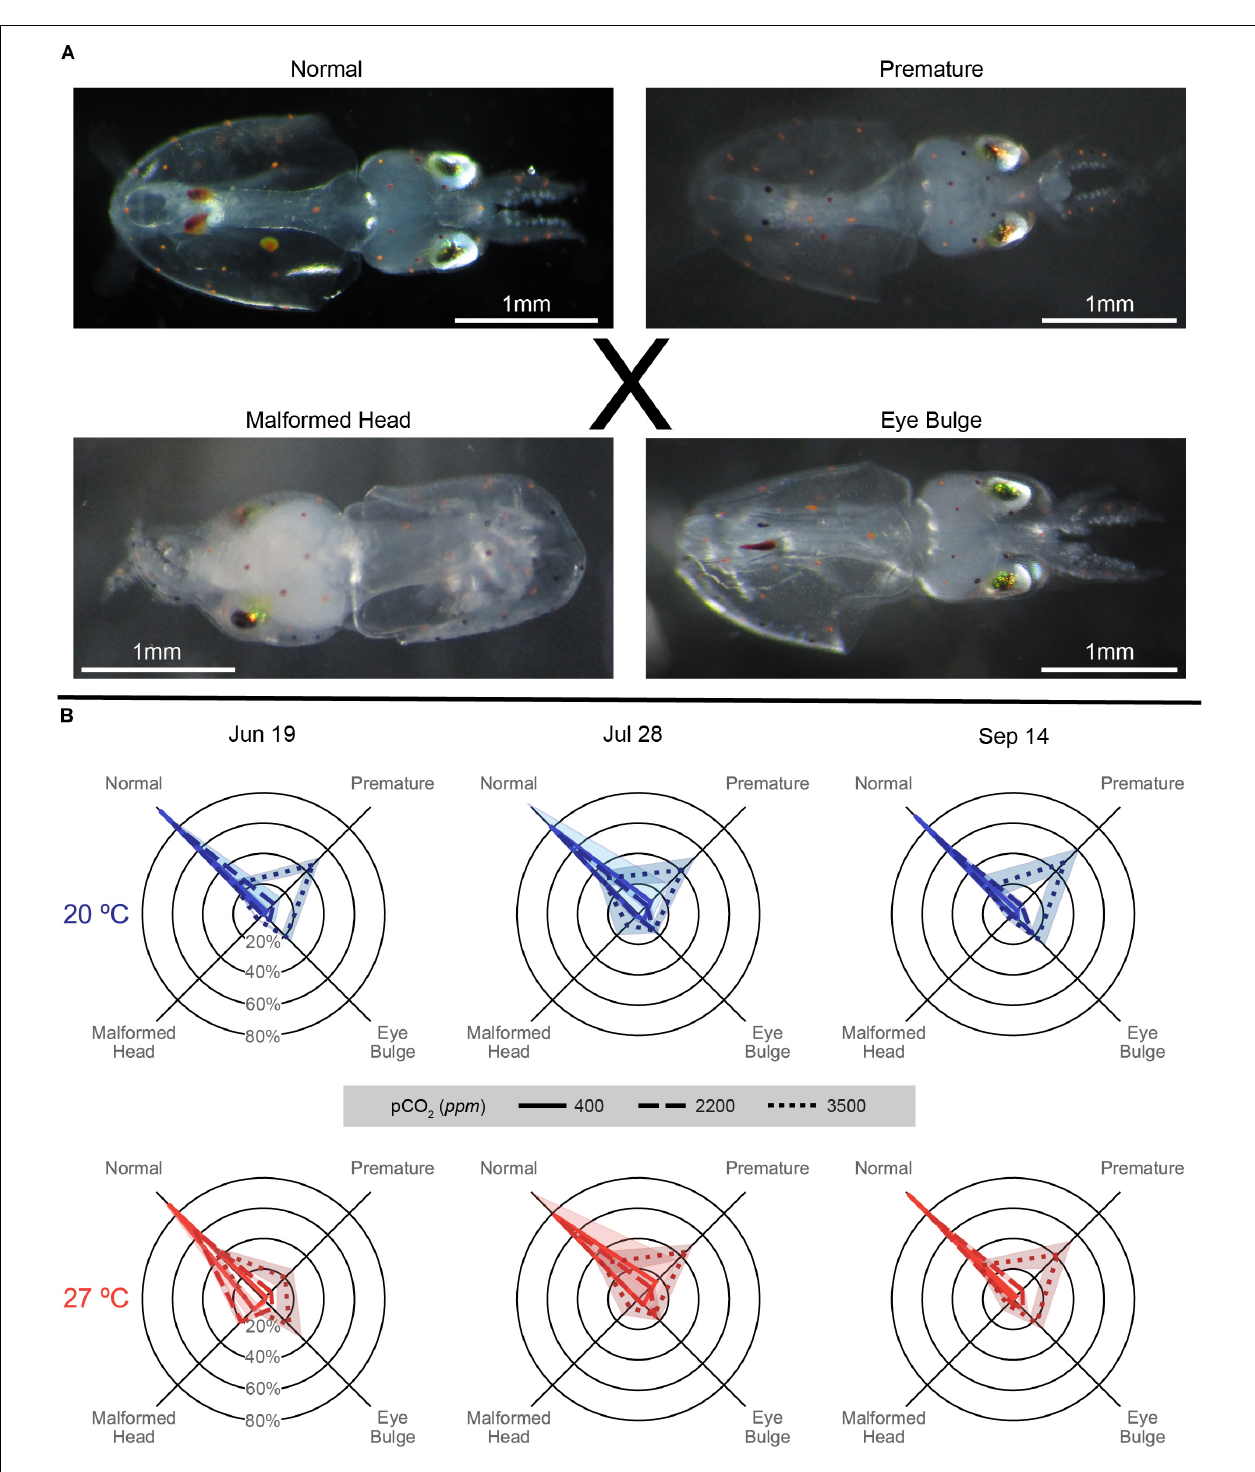
FIGURE 7 | (A) Images of types of hatched Doryteuthis pealeii paralarvae corresponding to the axes categories in the data figure (B) , as referenced by the ‘X.’ From top left: Normal: a typical hatchling paralarvae, Premature: a paralarvae showing remaining external yolk, Eye Bulge: a paralarvae with inflation of the membrane around the eye, and Malformed Head: a paralarvae with misshapen head, can also present with strange growths or misshapen mantle. All images have a unique 1 mm white scale line in the bottom left. (B) Malformation data for each trial (column title) on spider plots: axes represent categorical variables, while rings represent proportions of embryos in each category (labeled in June 19 plots). Categories include, clockwise from top left, Normal, Premature, Eye Bulge, and Malformed Head as depicted in (A) . Lines represent means, while shading represents one standard deviation. Line patterns and shade of color represent acidification treatments (smaller hash/darker color = more acidic). Plot position and data coloration represent temperature treatment (top/blue = 20 ◦ C, bottom/red = 27 ◦ C).